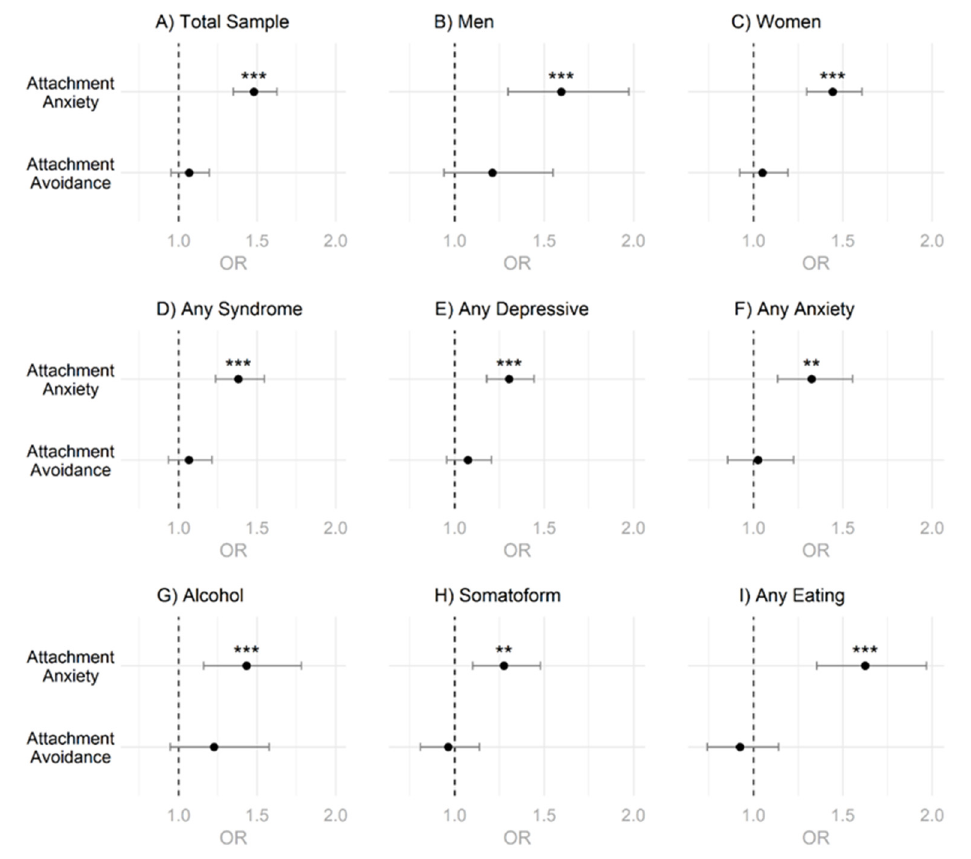
Figure 4. Odds Ratios for Attachment Dimensions and Current Psychotherapy Use. ( A ) Analysis for Total Sample. ( B ) Analysis for Men. ( C ) Analysis for Women. ( D – I ) Analysis for Specific Syndromic Groups. Note. OR = Odds Ratio. p -values were adjusted for multiple testing using the Holm–Bonferroni method. ** = p < 0.01, *** = p < 0.001.